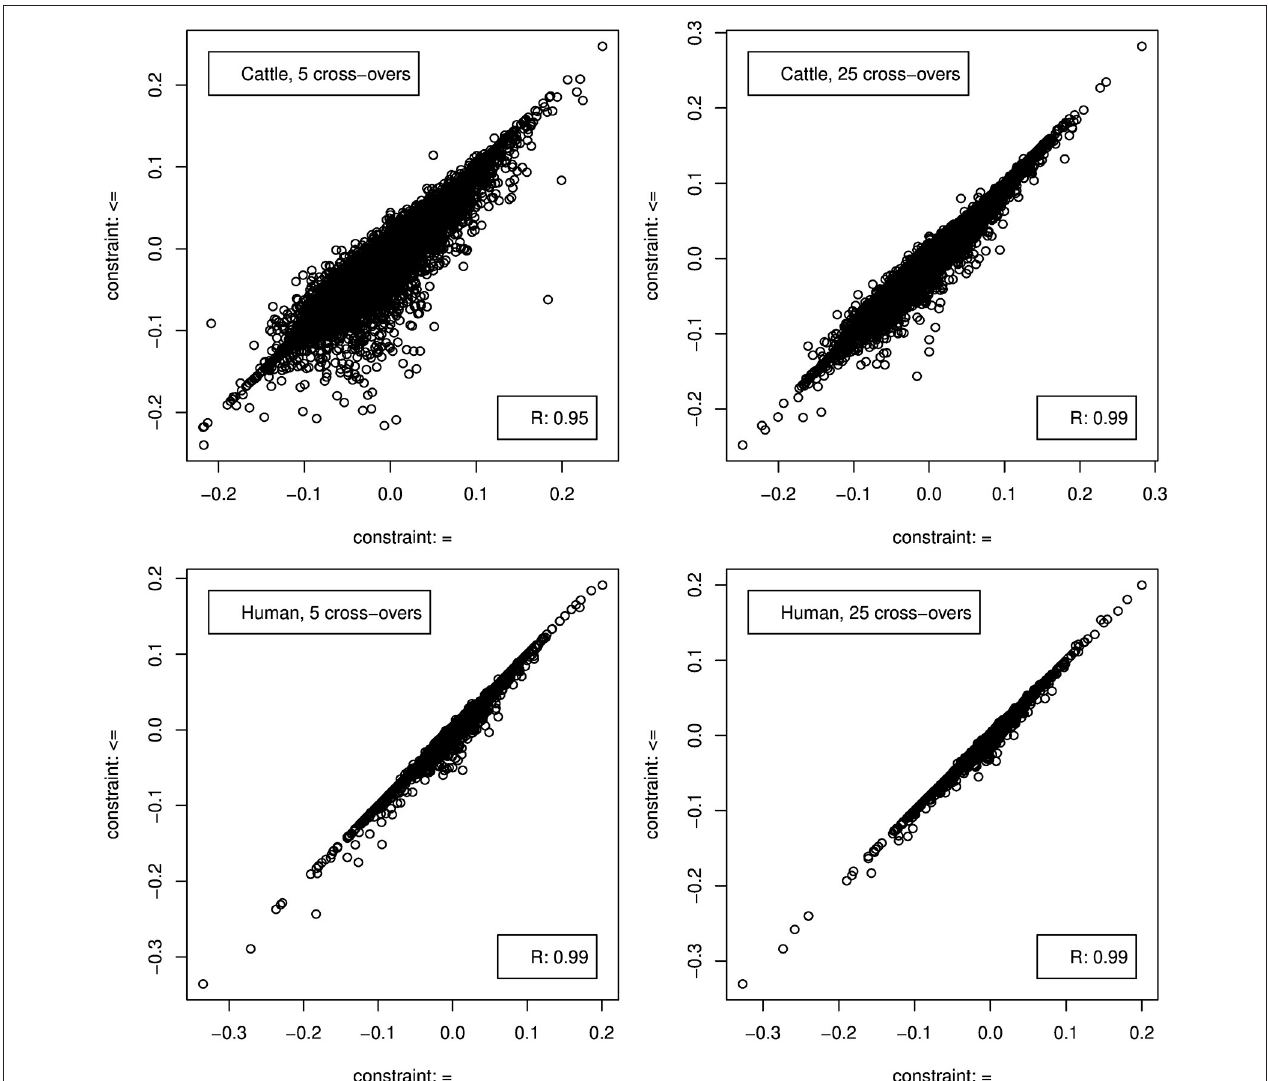
FIGURE 5 | Correlation between genome composition estimation errors when CGR was used either with constraint 5 (x-axis) or 6